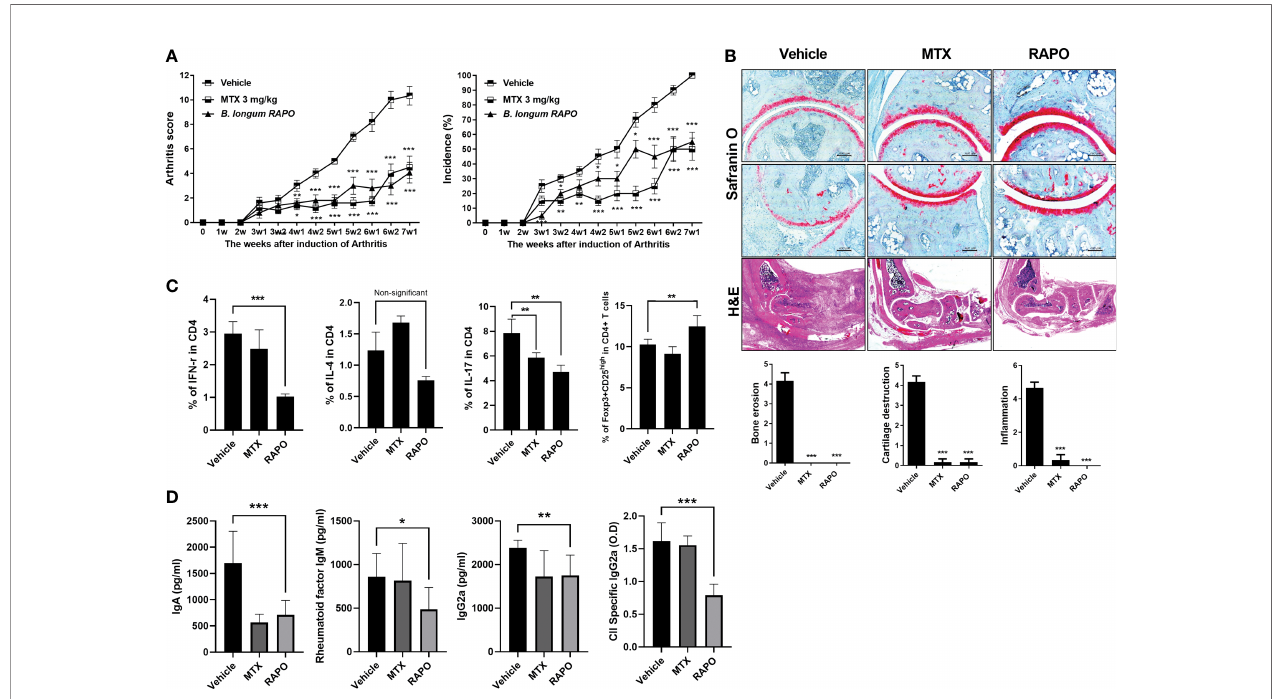
FIGURE 4 | Bi fi dobacterium longum RAPO alleviates RA in collagen-induced arthritis (CIA) mice. CIA mice ( n = 5 per group) were orally administered B. longum RAPO (1 × 10 8 CFU/mouse) or methotrexate (MTX; 3 mg/kg) once daily for 7 weeks after the immunization boost. (A) Reductions in arthritis score and arthritis incidence in CIA mice treated with B. longum RAPO. Effects of B. longum RAPO on RA development in CIA mice. (B) Tissue specimens were acquired from the hind paw joints of mice and stained with hematoxylin and eosin and safranin O. Representative histological quality and histological grades are shown. (C) Splenocytes isolated at 7 weeks after immunization were stimulated with phorbol myristate, ionomycin, and GolgiStop for 4 h. The percentages of Th1 (CD4 + IFN- g + ), Th2 (CD4 + IL-4 + ), and Th17 (CD4 + IL-17 + ) cells were analyzed using fl ow cytometry, including also Treg (CD4 + CD25 high Foxp3 + ). (D) Levels of IgA, IgM, IgG2a, and anti- CII-speci fi c IgG2a antibodies in the serum of CIA mice at 7 weeks after the fi rst immunization. Data are presented as the means ± SDs. * p < 0.05; ** p < 0.01; *** p < 0.001 ( vs . vehicle-treated